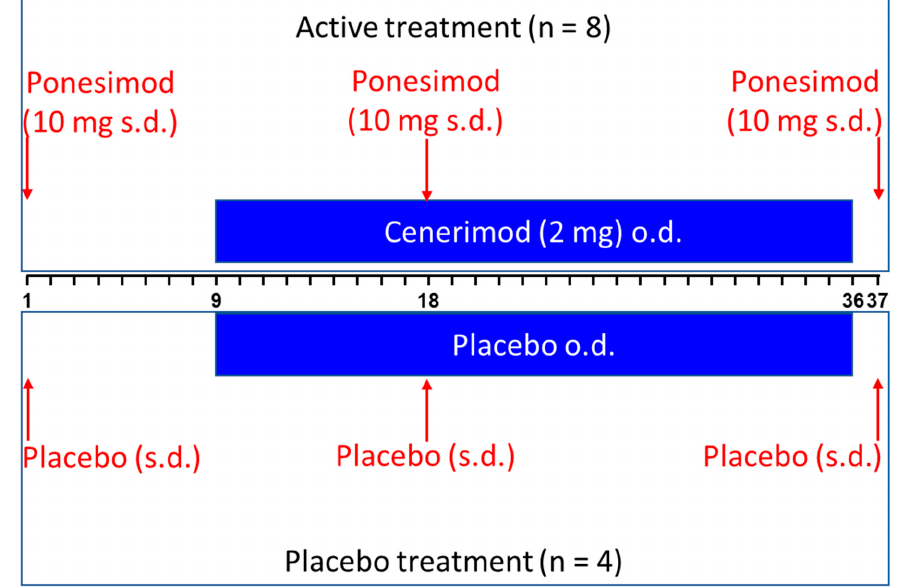
Figure 5. Study design. The red arrows represent the time of administration of ponesimod or its placebo (i.e., Day 1, 18, and 37). The blue bar represents the duration of o.d. administration of cenerimod or its placebo (from Day 9 to Day 36). o.d. = once daily; s.d. = single